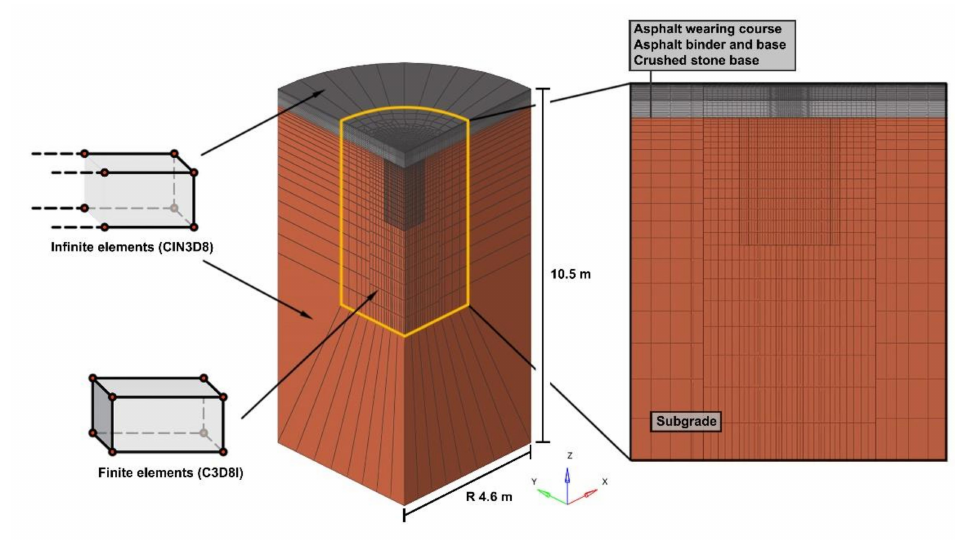
Figure 2. The analysed domain of the road pavement structure and its finite element